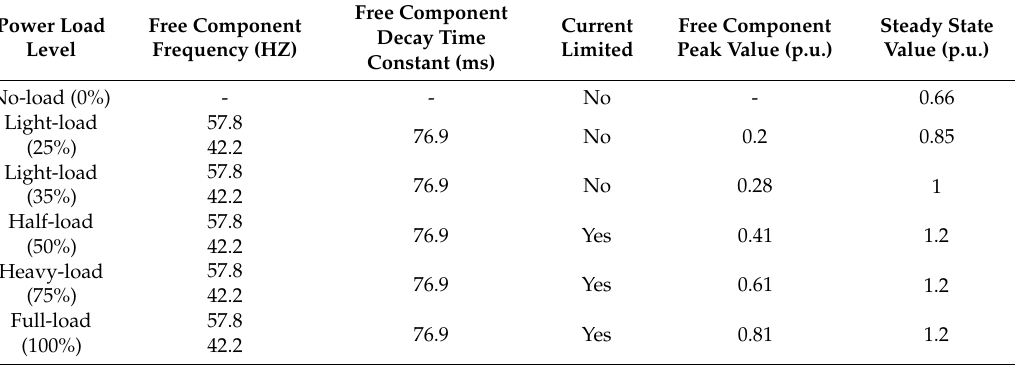
Table 4. Influence of PV power